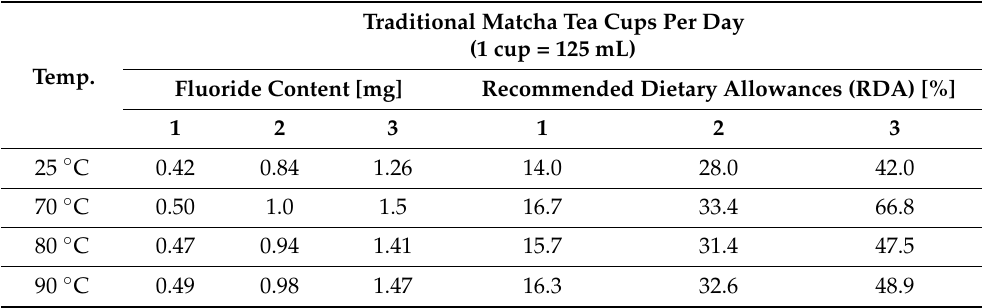
Table 3. The concentration of fluoride in traditional matcha infusions depending on the water temperature and the percentage of the Recommended Dietary Allowance (RDA) for the diet.